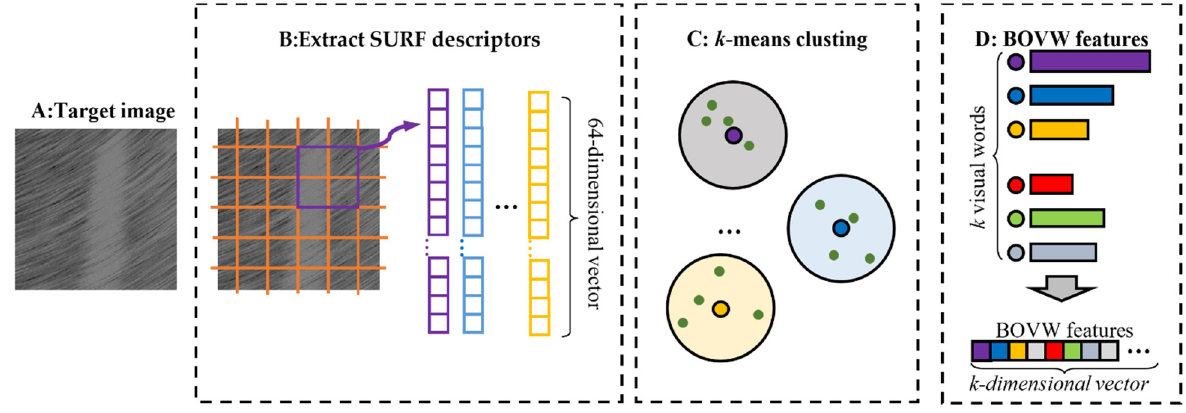
Figure 2. BOVW feature extraction from water column images based on SURF.